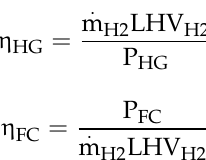
Figure 5. Proposed plant logic diagram.